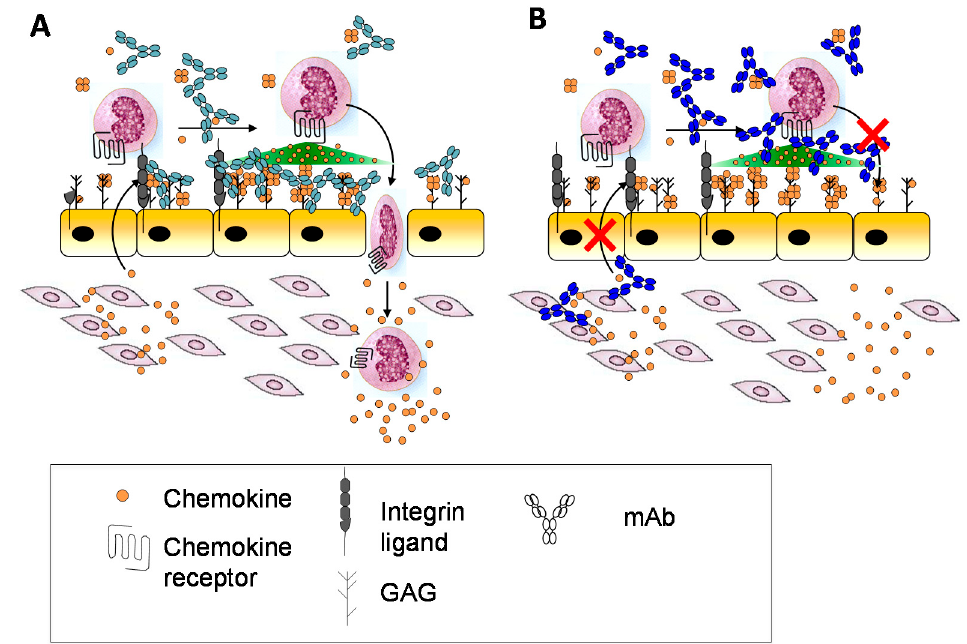
Figure 6. Proposed modes of action of antibodies 1B6 and 1F11. In the updated model of chemokine activity the directional signal is produced by a localized cloud of soluble chemokine. ( A ) The majority of 1B6 molecules are bound to GAG-displayed CXCL10 and free chemokines in the soluble gradient are not inhibited. ( B ) The binding of the antibody to soluble chemokines inhibits cell migration induced by the soluble chemokine cloud and may interfere with the formation of the chemokine gradient.